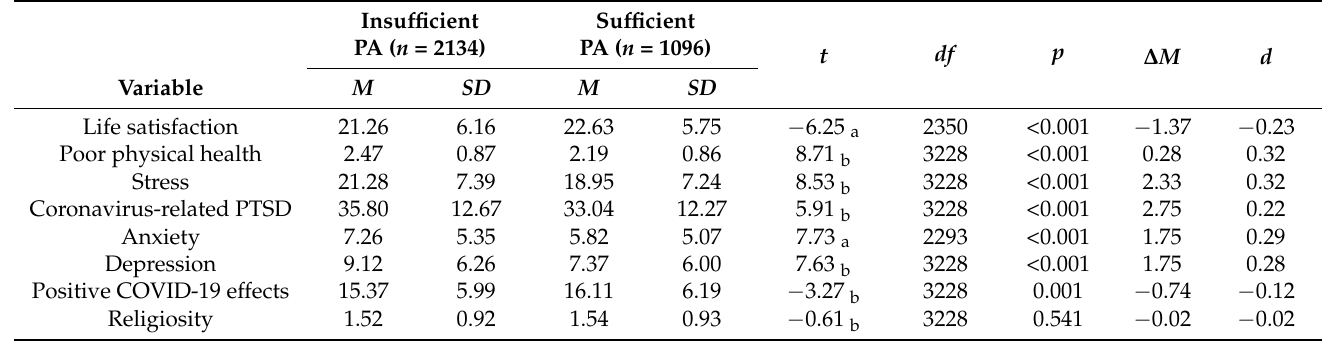
Table 5. A comparison of samples with sufficient and insufficient PA in mental and physical health.